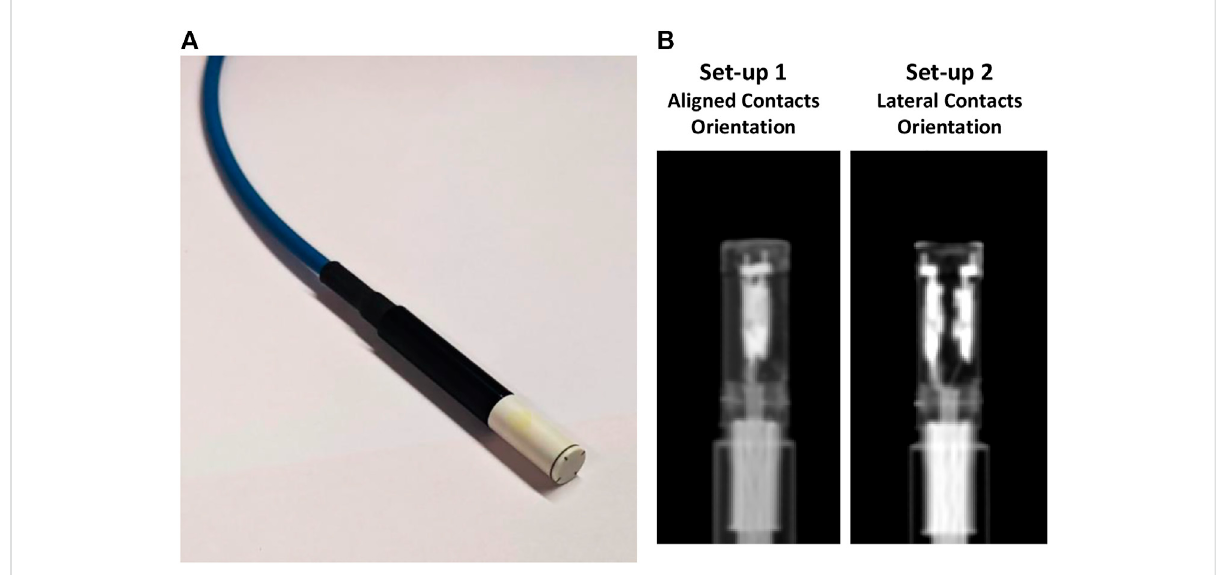
FIGURE 1 (A) The microDiamond detector. The long axis is from the stem to the front face. Measurements on the AusMRI-linac were through the front face. Measurements on the Unity were perpendicular to the long axis in an “ edge on ” orientation. MicroDiamond set up for measurements on conventional linacs, used for calculation of magnetic fi eld correction factors, replicated the set-up on each of the MRI-linacs. (B) MV EPID image of the microDiamond in the two edge on set-ups used for determination of magnetic fi eld correction factors from a conventional linac to a perpendicular MRI-linac. Set-up 1 has the contacts aligned with the beam axis in an anterior and posterior position relative to the collecting volume. Set-up 2 has contacts laterally positioned relative to the collecting